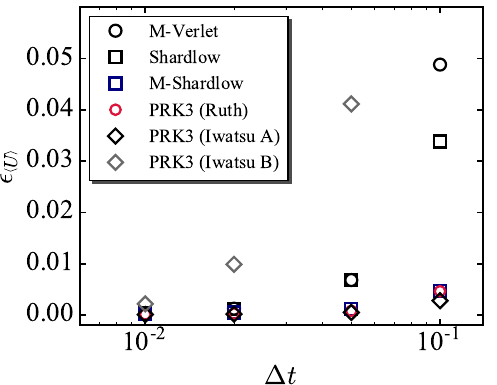
Figure 4. Error in potential energy calculated using Equation (22) as a function of ∆ t on different time integration